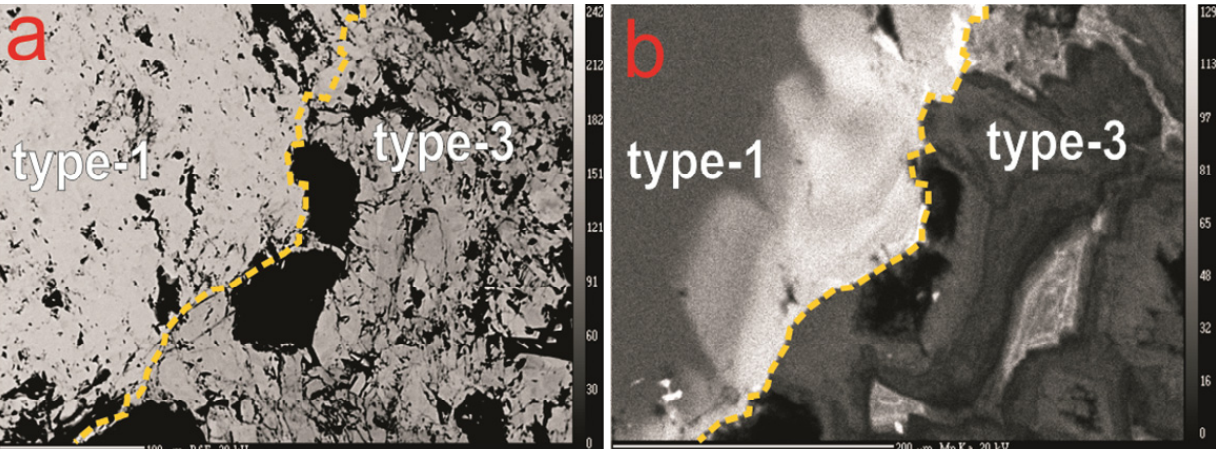
Figure 8. Contact zone between type-1 and type-3 ferberite (yellow outline) by backscatter electron images ( a , d ) and element mapping ( b , c , e , f ) of the two areas on polished section 1 from Bugarama deposit (marked in Figure 5a) using electron microprobe. The images ( a )–( c ) are taken from the left square, and ( d )–( f ) are taken from the right box on Figure 5a. Element mapping shows the distribution of the Mn ( b , e ) and Mg ( c , f )